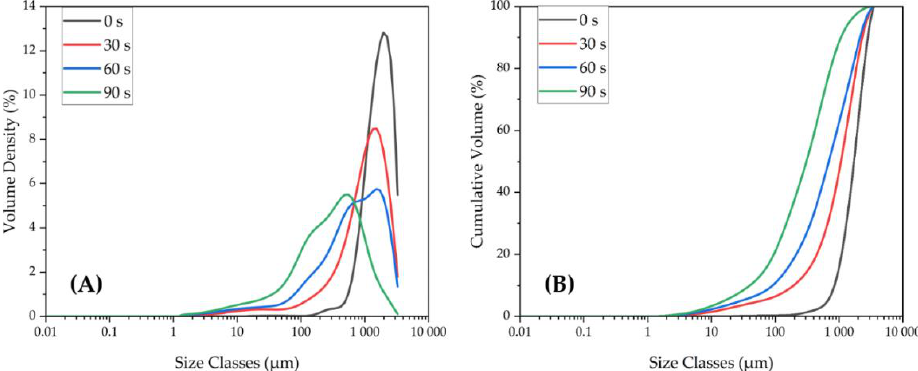
Figure 7. ( A ) The frequency distributions of the ground flotation underflow. ( B ) The cumulative distributions of the ground flotation underflow.